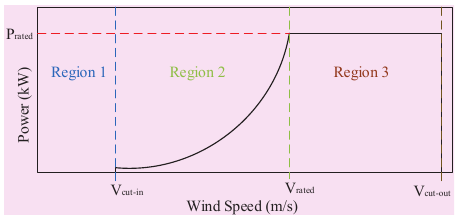
Figure 1. Main operating regions of the wind